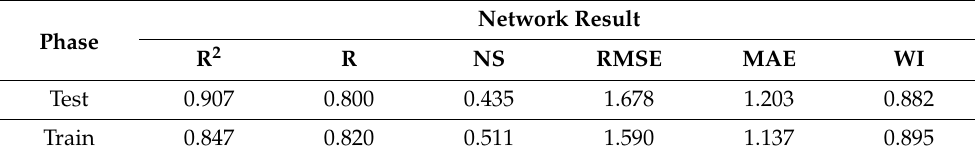
Table 6. Best obtained results for normalised load estimation.